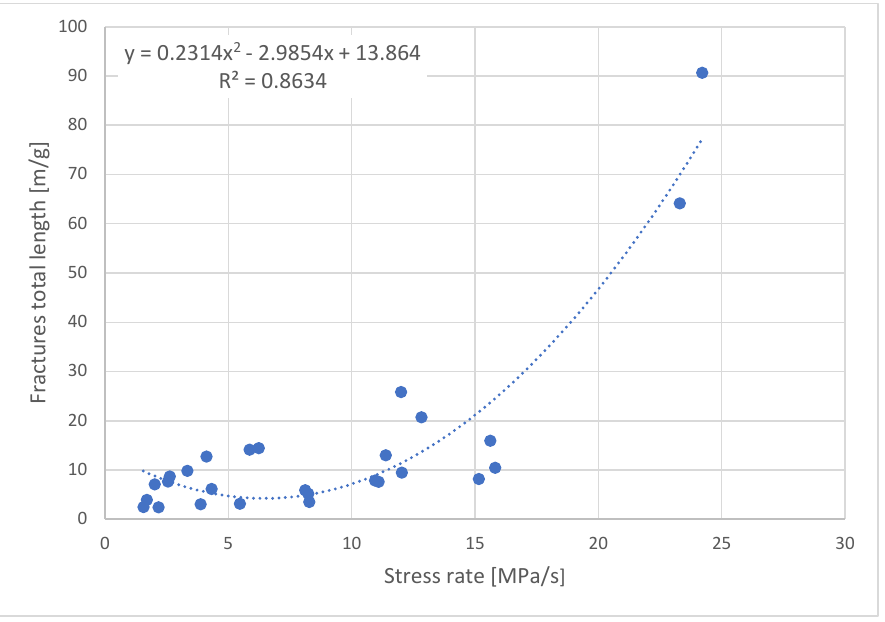
Figure 4. Correlation between the stress rate and total fracture